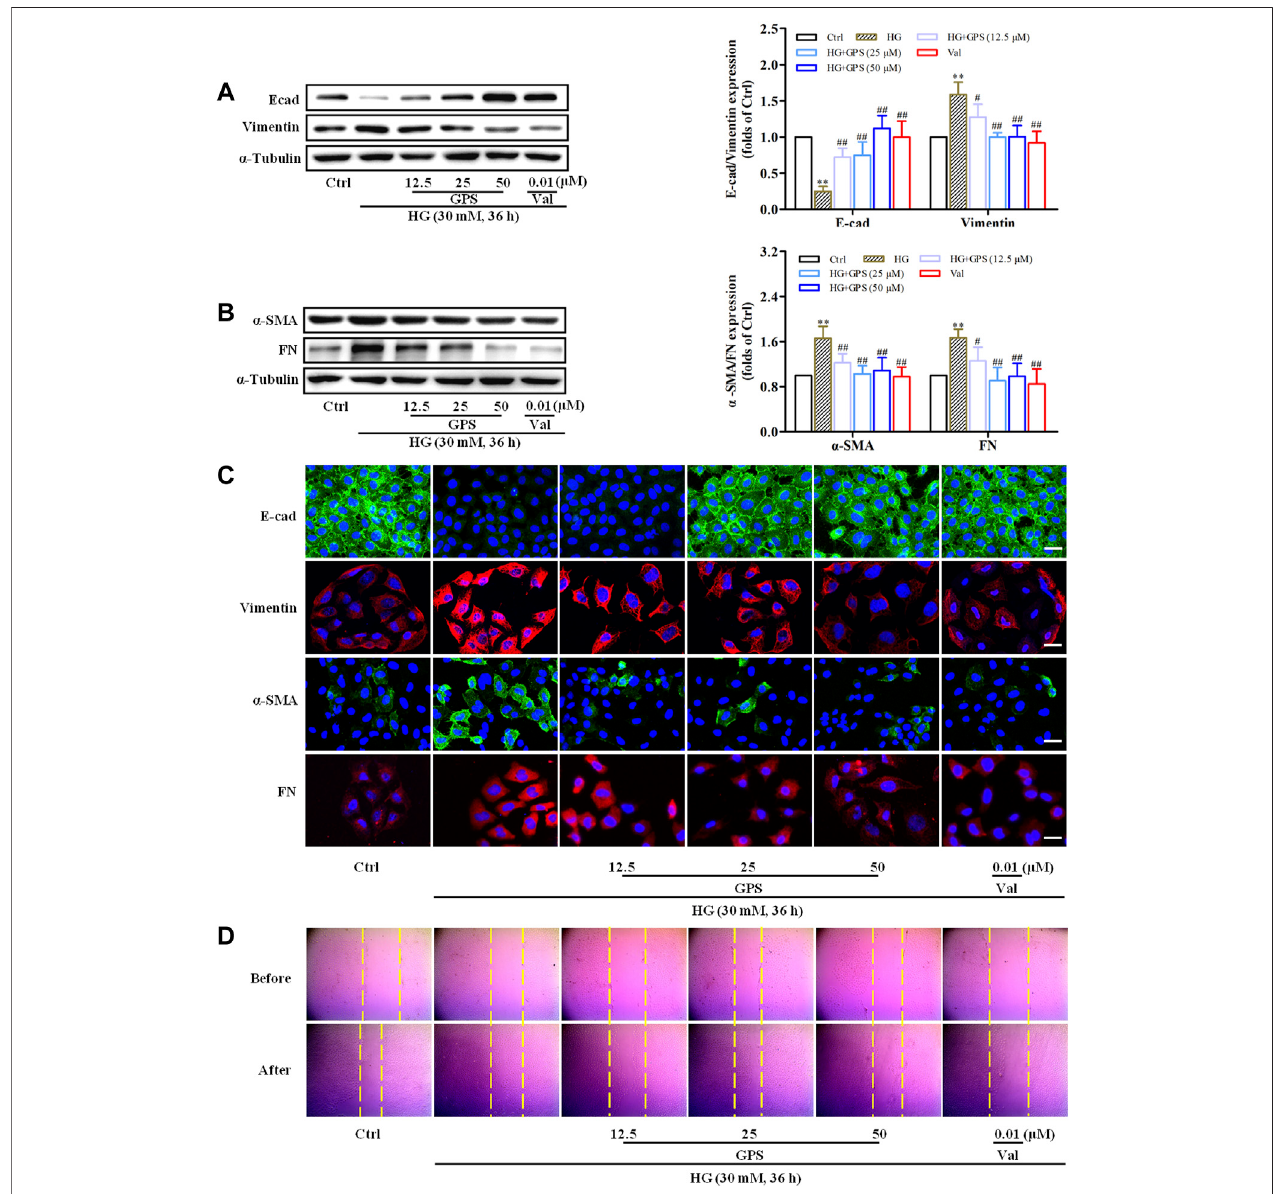
FIGURE 5 | GPS inhibited HG-induced EMT in NRK-52E cells. (A,B) Protein levels of E-cad, vimentin, α -SMA, and FN after GPS intervention were detected by Westernblot. (C) ProteinlevelsofE-cad,vimentin, α -SMA,and FNafter GPSinterventionweredetected byimmuno fl uorescence. Scalebar:20 μ m. (D) Migrationability of NRK-52E cells after GPS intervention was detected by a cell scratch test. ** p < 0.01 vs . Ctrl, ## p < 0.01 and # p < 0.05 vs . HG. Data were expressed as mean ± SD.